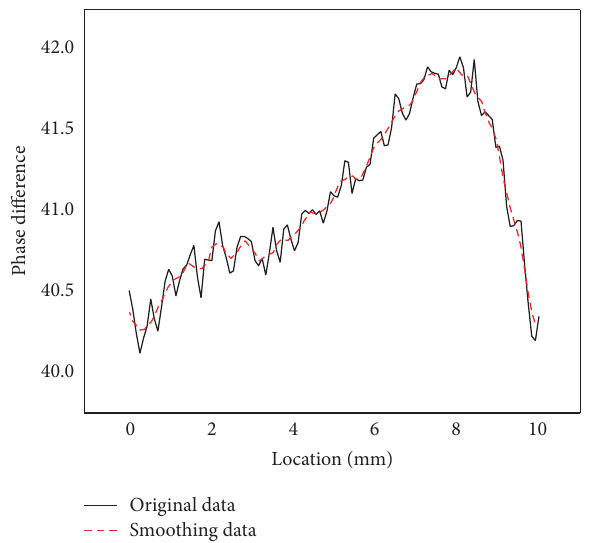
Figure 9: Phase difference of different layers of laminated directional PMMA.